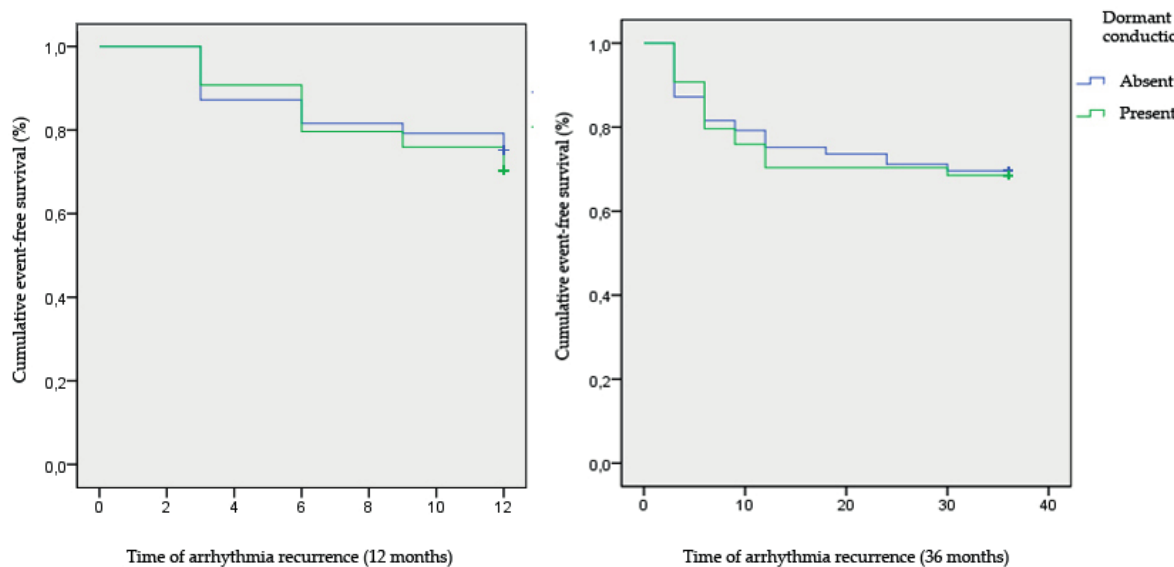
Fig. 2. Kaplan-Meier curve of cumulative event free survival.